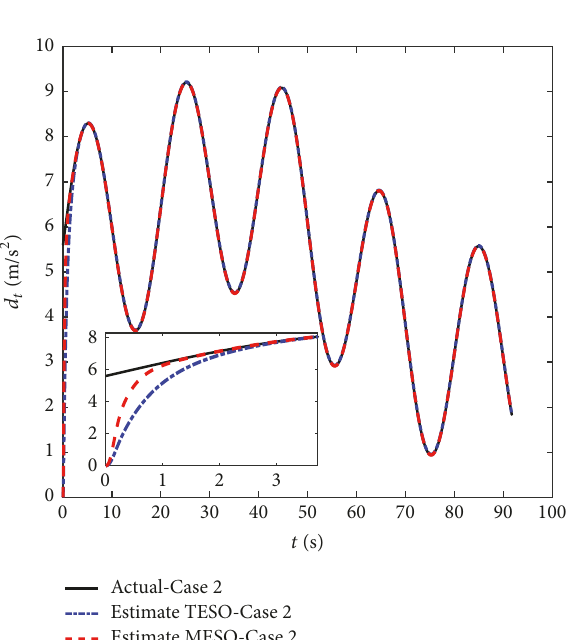
Figure 9: Variation of the fuel mass flow.